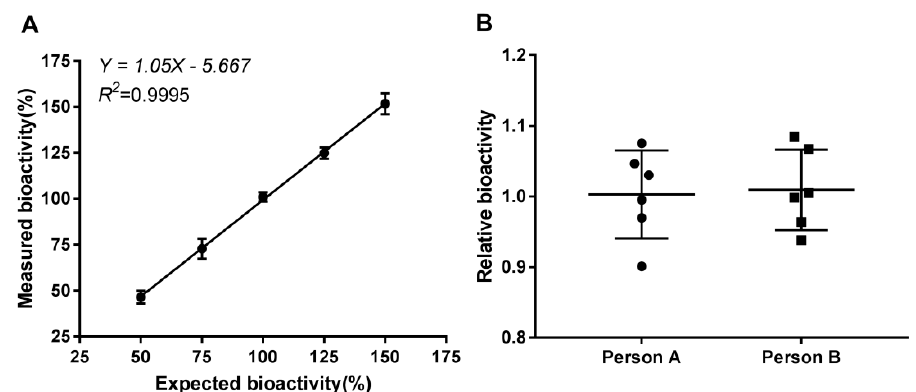
Figure 4. The results of the linearity and intermediate precision tests. ( A ) Linearity plot for the expected bioactivity against the measured bioactivity. Each point indicates the mean of three replicates. ( B ) Intermediate precision. Tests of six batches of rhKGF-1 were performed by two persons on different days. The mean ± SD and representative linear regression of four independent experiments is shown.